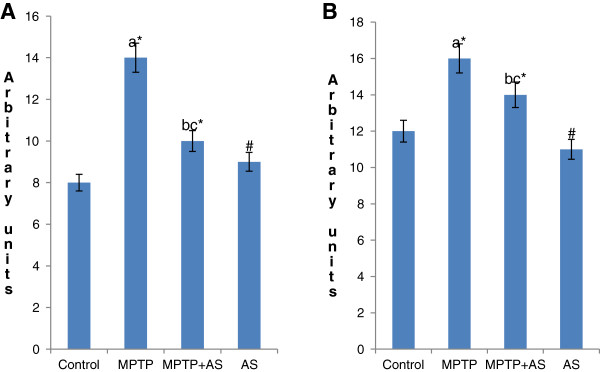
Each bar represented the mean ± S.D of 6 mice (n = 6). * represents statically significance at P < 0.05. Comparasion were made as (a) group I vs group II, (b) group II vs group III, (c) group I vs group III, (#) non significant group I vs group IV (scale bar 50 μm) A: Densitometric pattern of the expression of BAX in the striatum. B: Densitometric pattern of the expression of BAX in the midbrain.